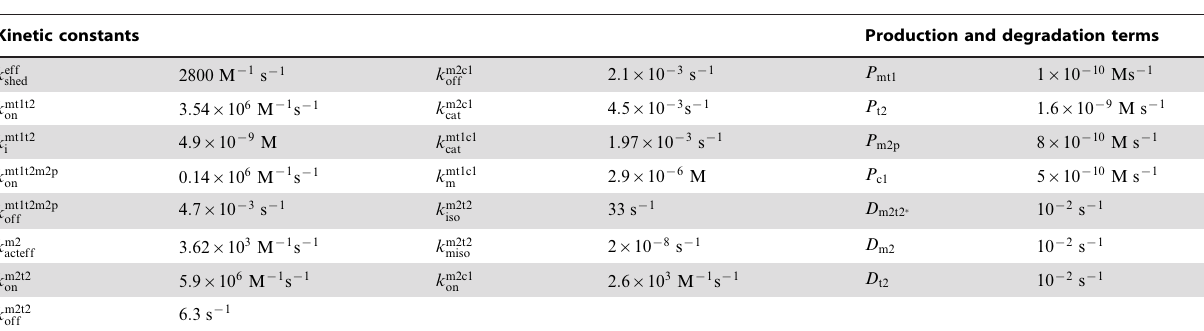
Table 3. Nominal values for the parameters.